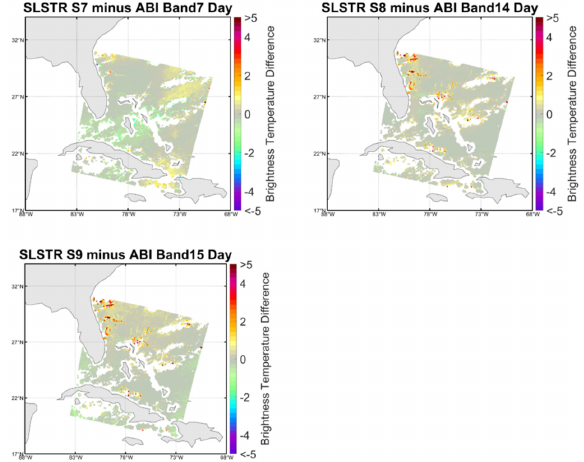
Figure 4. Distributions of the daytime brightness temperature (BT) differences between SLSTR and ABI in the eastern tropical North Atlantic Ocean of SLSTR S7 ( top ‐ left ), S8( top ‐ right ) and S9 ( bottom ‐ left ). The colors indicate the SLSTR minus ABI equivalent BTs.